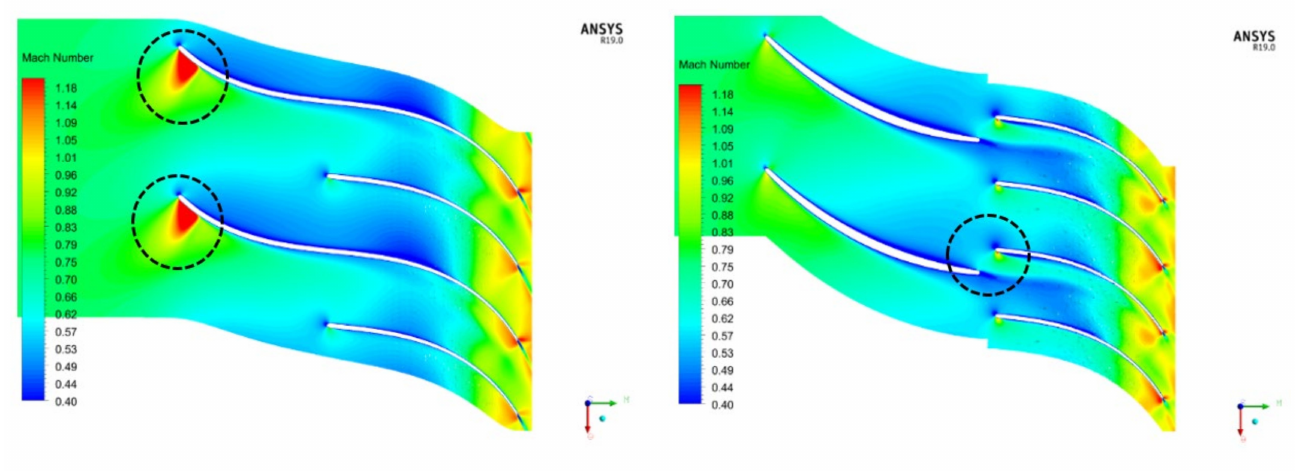
Figure 14. Relative Ma contours for the conventional ( left ) and tandem compressor ( right